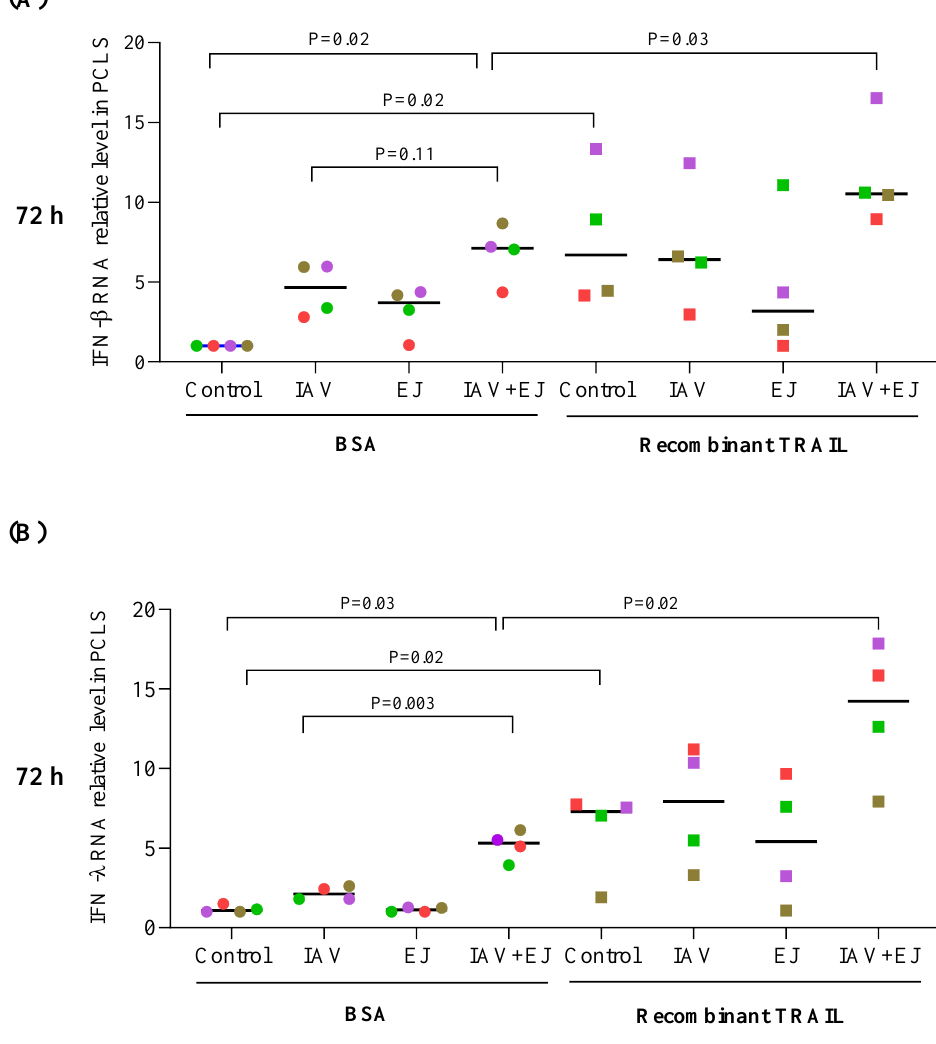
Figure 5. Recombinant TRAIL increased IFNs in human precision-cut lung slices (PCLS) treated with E-juice and influenza A virus (IAV). PCLS were treated with IAV and E-juice (EJ) in the presence or absence of BSA (control) and recombinant TRAIL (10 ng/mL) for 72 h. Levels of IFN- β ( A ) and IFN- λ ( B ) in the tissue were analyzed by RT-PCR. Each data point (colored dot) represents the average of 3 replicates from each respective individual donor ( n = 4 donors). Horizontal lines indicate medians; Mann – Whitney test was used to analyze the data.